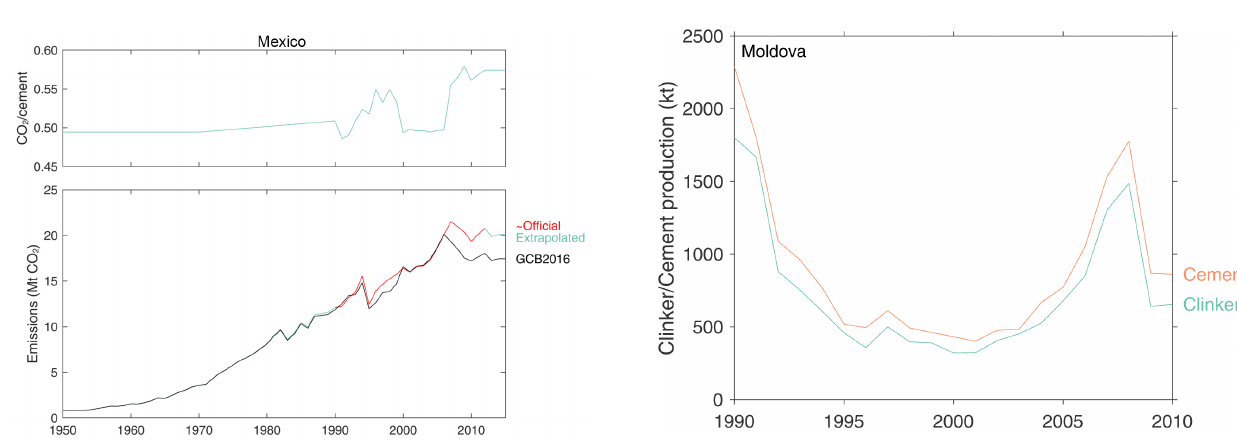
Figure C26. Revised cement emissions for Mexico.